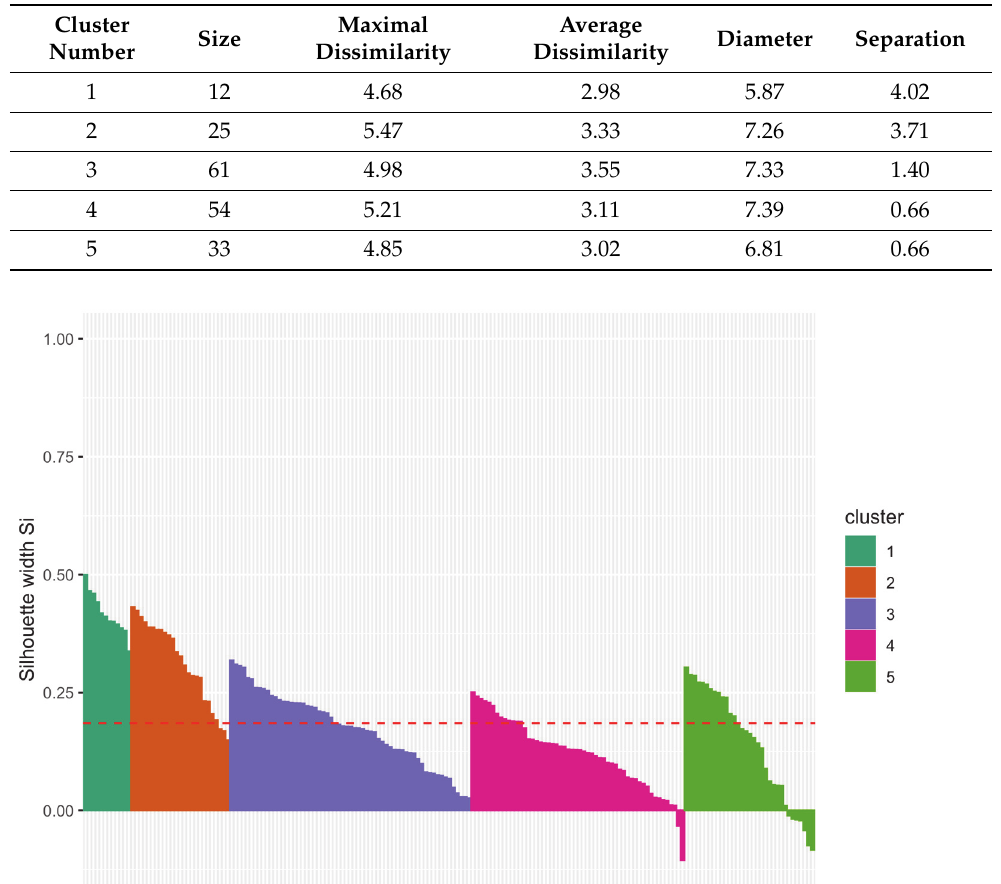
Figure 3. Silhouette plot of clusters obtained from the k-medoid algorithm.